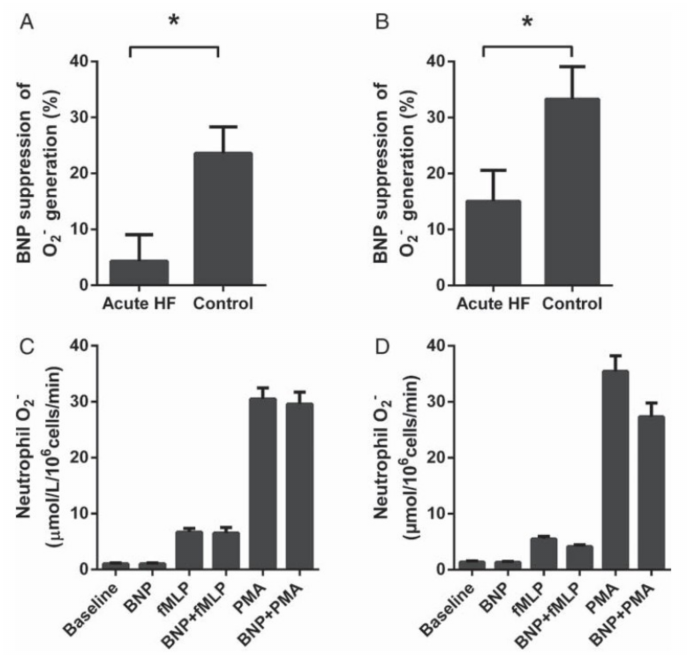
Figure 3. Comparison of BNP effects on phorbol 12-myristate 13-acetate (PMA)-stimulated ( A ) and N -formyl-methionyl-leucyl-phenylalanine (fMLP)-stimulated ( B ) O 2 − generation by neutrophils from acute heart failure patients ( n = 45) and control subjects ( n = 29). ( C , D ) Raw data for actual O 2 −